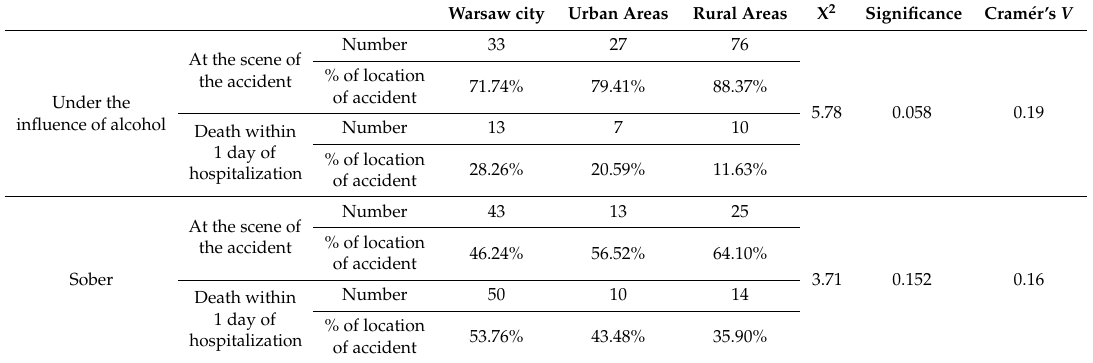
Table 8. Number of victims by location of accident, location of death, and group. Warsaw city Urban Areas Rural